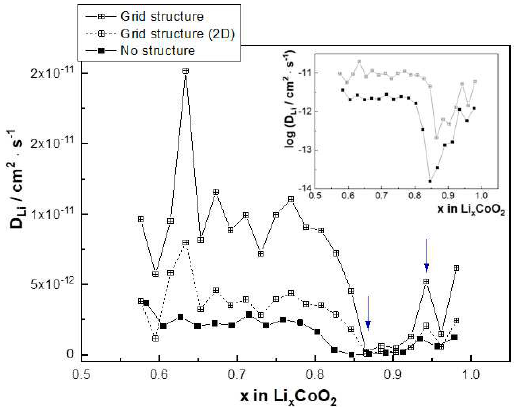
Figure 4. Measured variables in the galvanostatic intermittent titration technique (GITT) for the evaluation of diffusion coefficient: ( a ) transient E τ and ( b ) equilibrium E s potentials. Insets are illustrating the shaded part of the measured current pulse, which is taken into account for the respective potential.